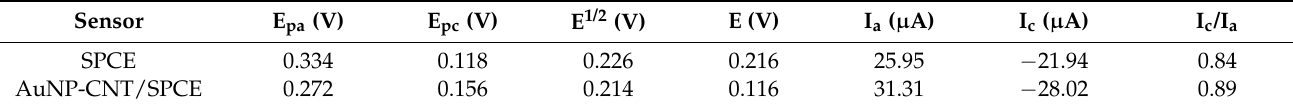
Table 1. Electrochemical parameters obtained from cyclic voltammograms of the sensors immersed in K 4 [Fe(CN) 6 ] 10 − 3 M-KCl 10 − 1 M solution.